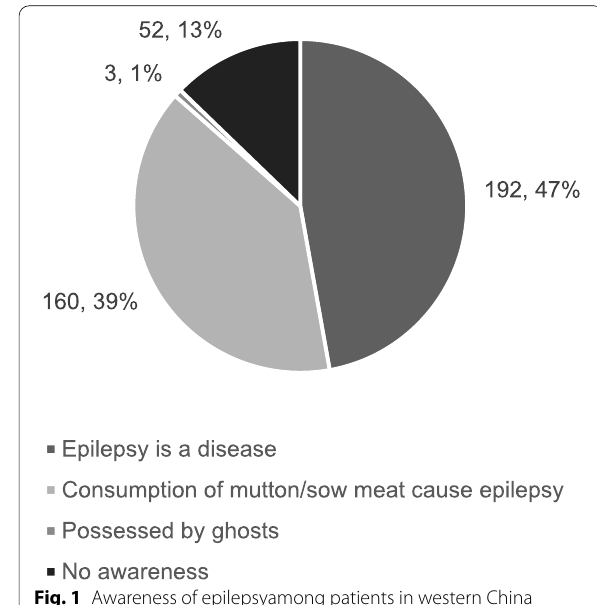
Fig. 1 Awareness of epilepsyamong patients in western